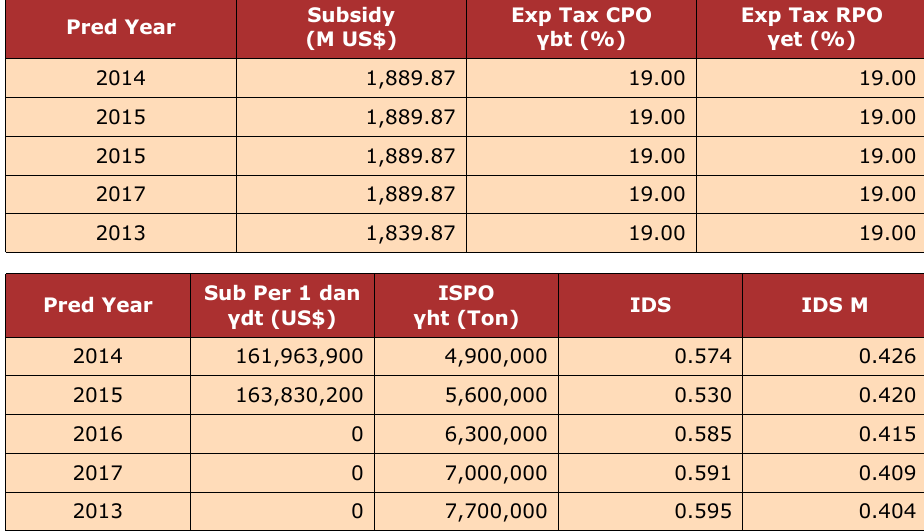
Table 4. Model Output: Policies and